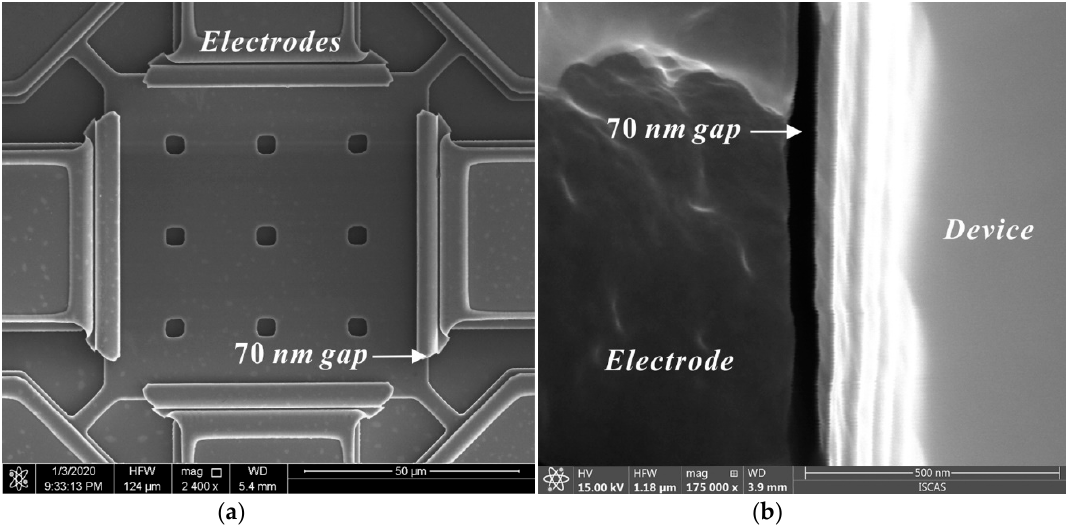
Figure 5. SEM picture of the fabricated Lamé-mode resonator ( a ) and the cross-section of the capacitive 70 nm gaps ( b ).